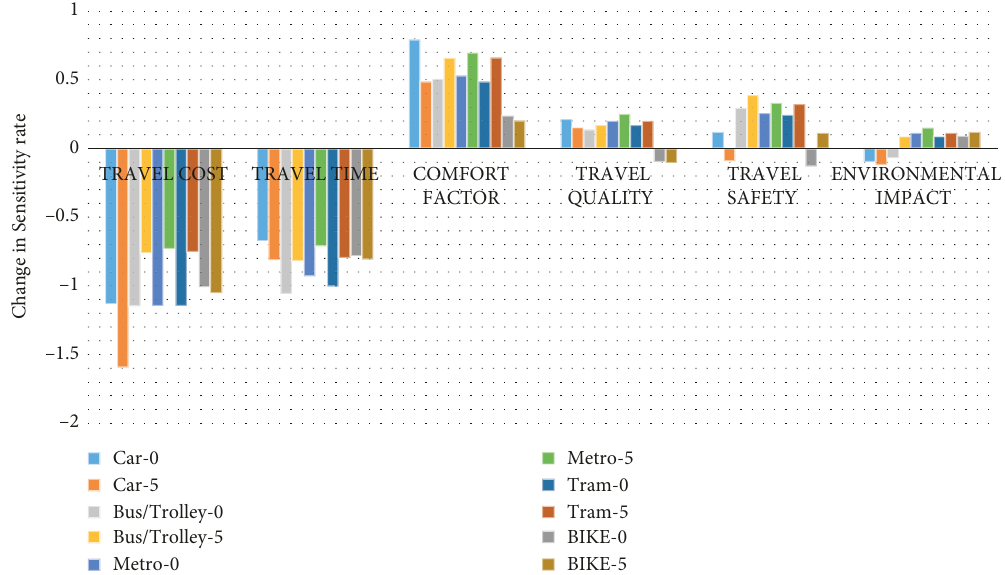
Figure 13: Comparisons between the physical and sensory parameters of the mode choice based on the first and the fifth